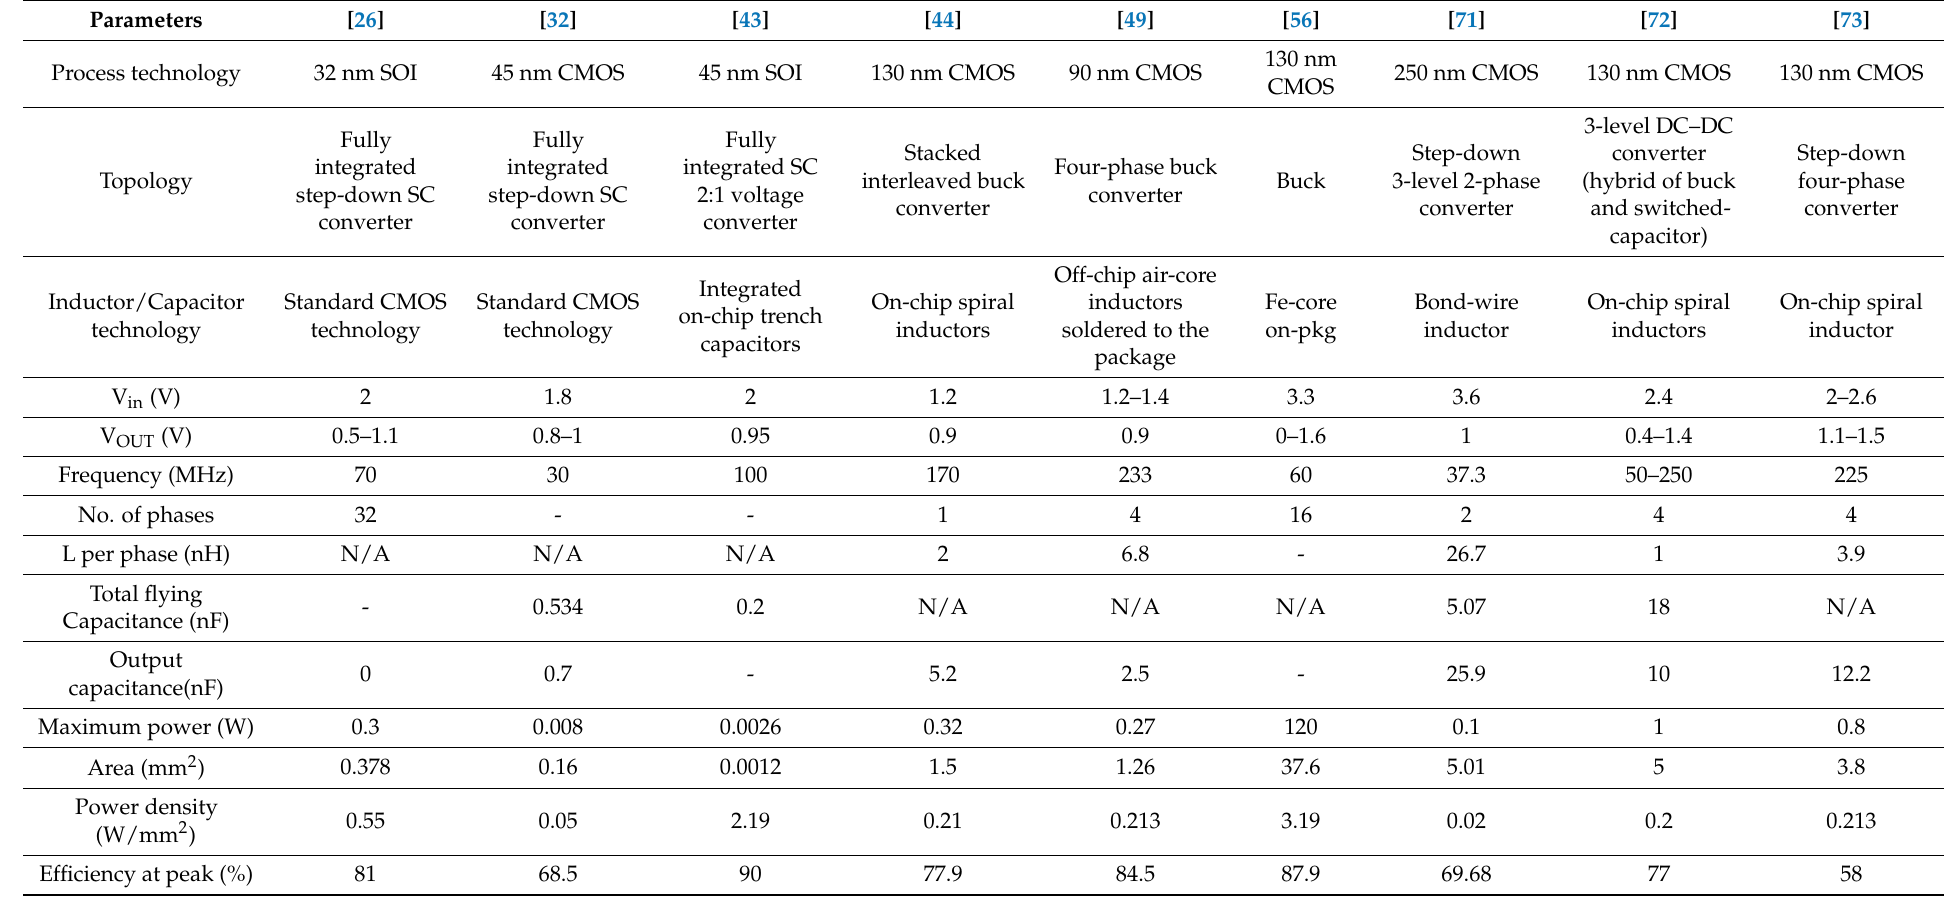
Table 3. Performance comparison of step-down DC-DC converter designs based on on-chip-integrated passive